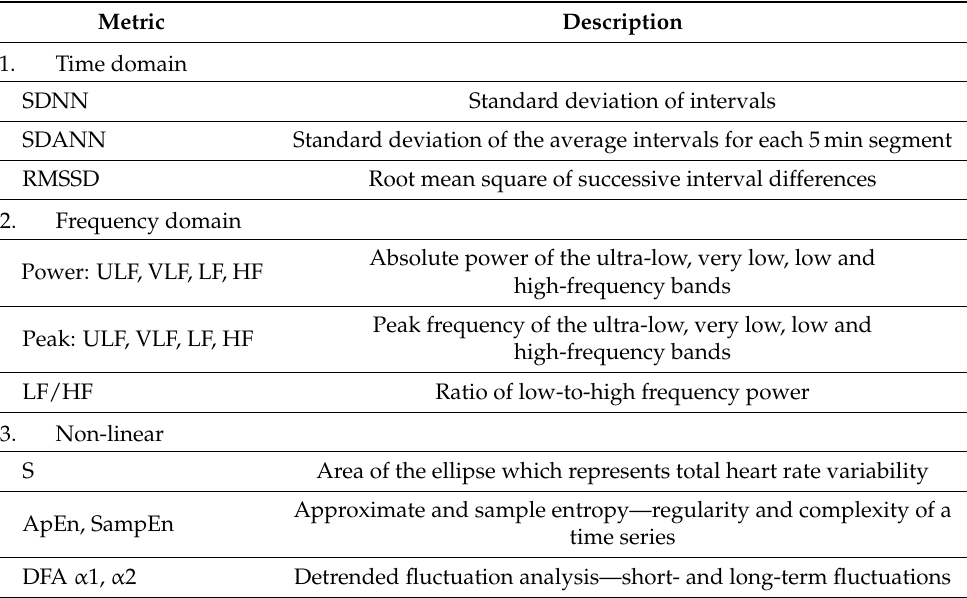
Table 2. Common metrics of heart rate variability (conventionally, RR or NN